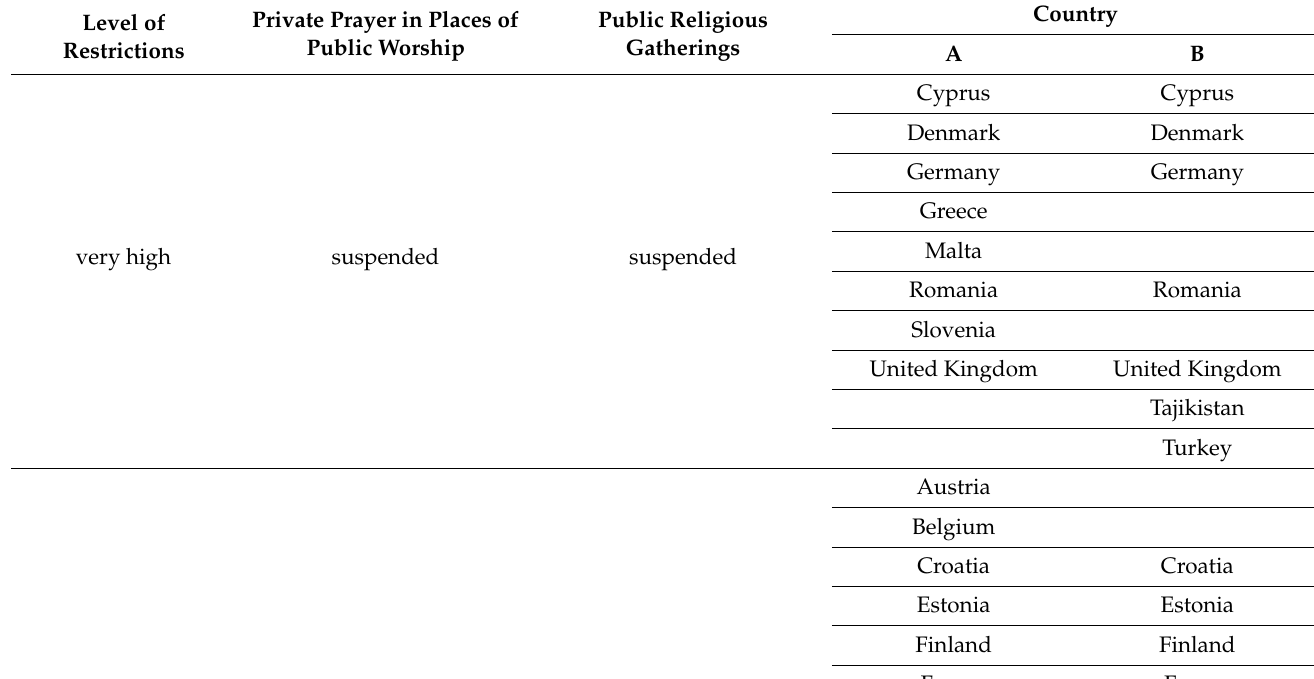
Table 1. The restrictiveness of selected OSCE countries regarding religious freedom due to COVID-19 during the first wave of the pandemic based on data provided by Alexis Artaud de La Ferri è re (column A) and the Organization for Security and Co-operation in Europe (OSCE)/Office for Democratic Institutions and Human Rights (ODIHR) (column B). Level